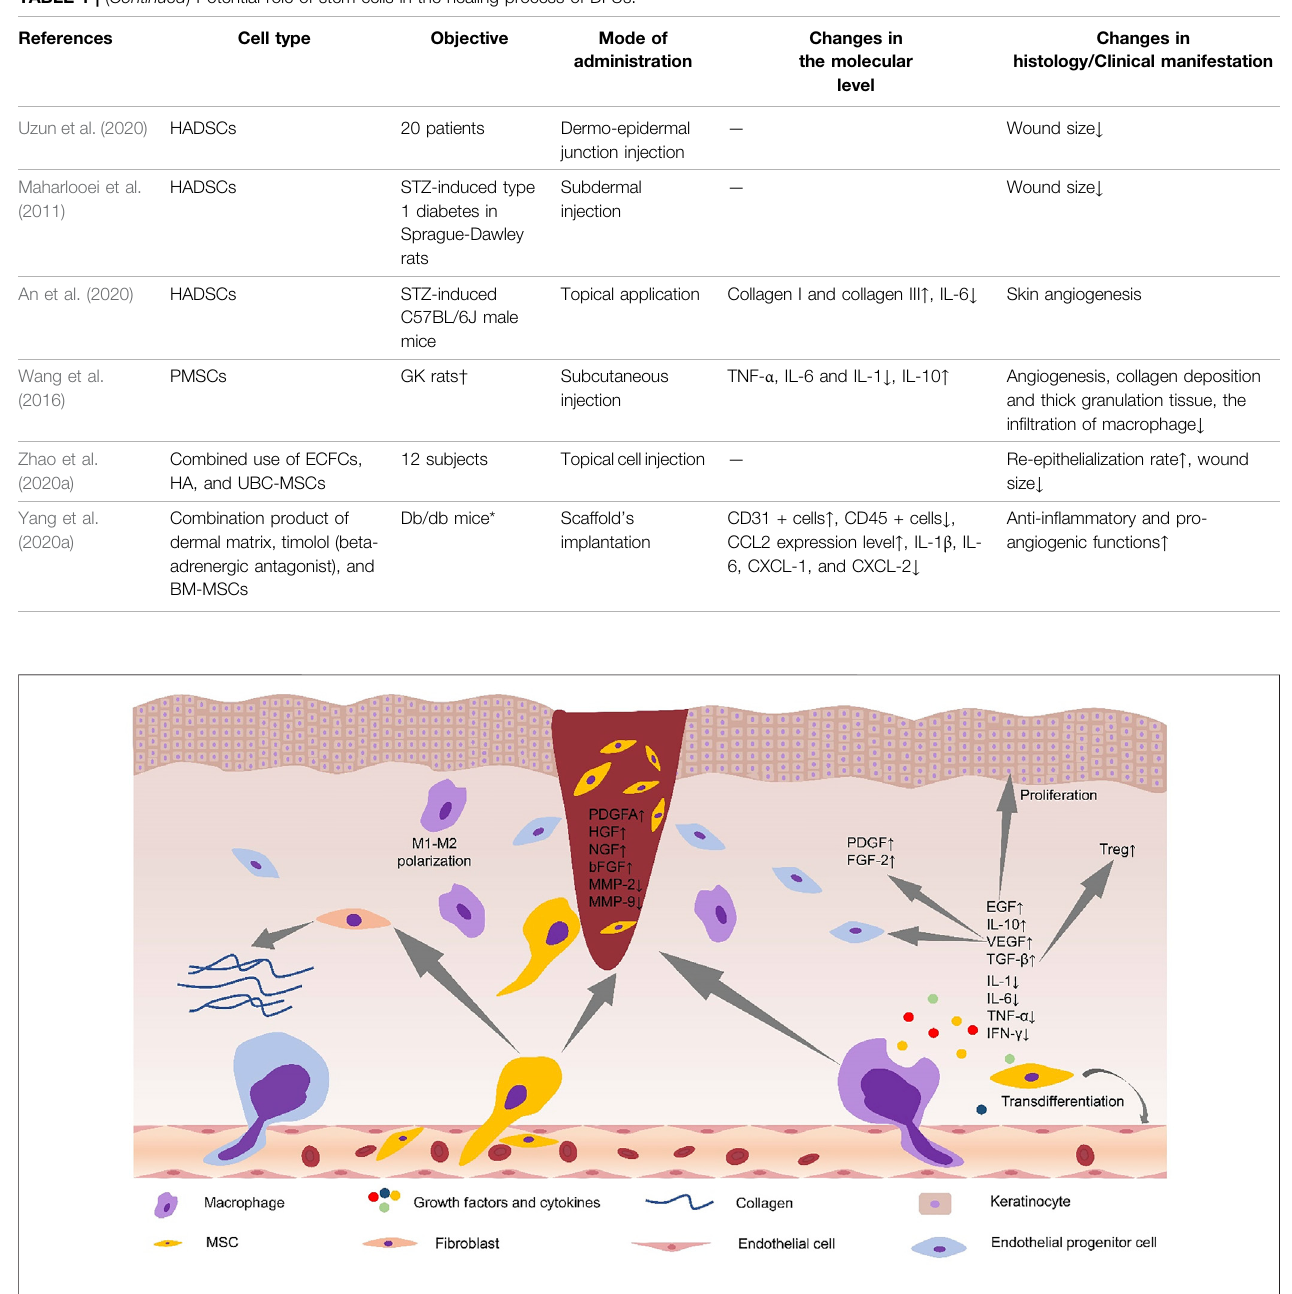
FIGURE 1 | Alterations in the microenvironment of diabetic foot ulcers after stem cell application. Stem cells promoted M2 polarization of macrophages and secretionofanti-in fl ammatorycytokines.StemcellsincreasedthelevelsofPDGFA,HGF,NGF,andbFGFinthewoundsite,anddecreasedthelevelsofMMP-2,MMP-9, and proin fl ammatory cytokines. Stemcellspromotedcollagendepositionbyacting on fi broblasts. IncreasedlevelsoflocalVEGFcanrecruitEPCstothewoundsiteand increase the levels of PDGF and FGF-2. EGF can promote the proliferation of keratinocytes, and TGF- β can regulate local immunity by increasing the levels of Treg cells. MSC, mesenchymal stem cell; PDGFA, platelet-derived growth factor A; HGF, hepatocyte growth factor; NGF, nerve growth factor; bFGF, basic fi broblast growth factor; MMP-2, matrix metaroprotease-2; MMP-9, matrix metaroprotease-9; FGF-2, fi broblast growth factor; EGF, epidermal growth factor; IL-10, interleukin-10; TNF- α , tumor necrosis factor- α ; Tregs, regulatory T cells; IFN- γ , interferon- γ ; TGF- β , transforming growth factor- β .